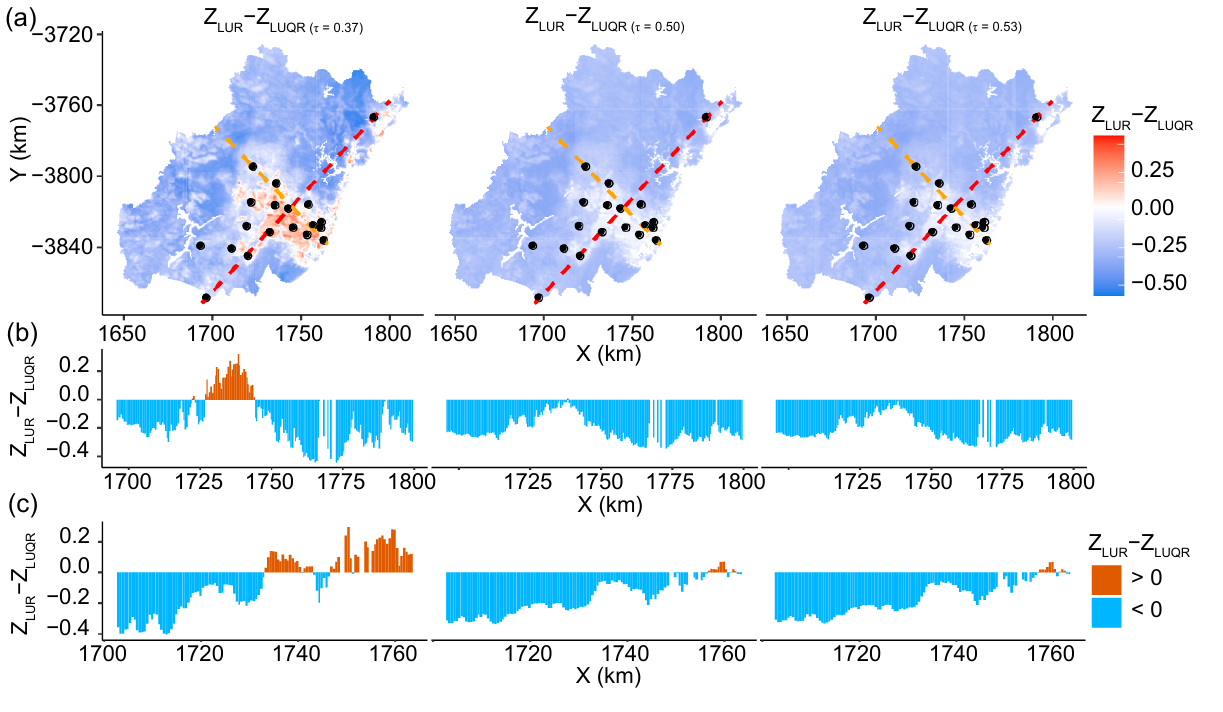
Figure 8. Spatial distributions of the difference between LUR-based prediction ( Z LUR ) and LUQR- based prediction ( Z LUQR ) ( a ), and transect along red ( b ) and orange ( c ) lines. (“Z” is predictions of